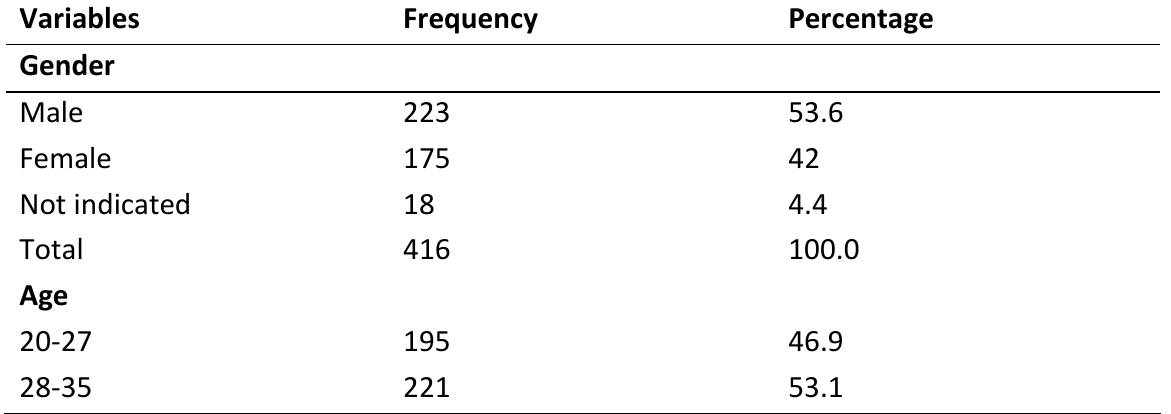
Table 1. Demographic Profile of